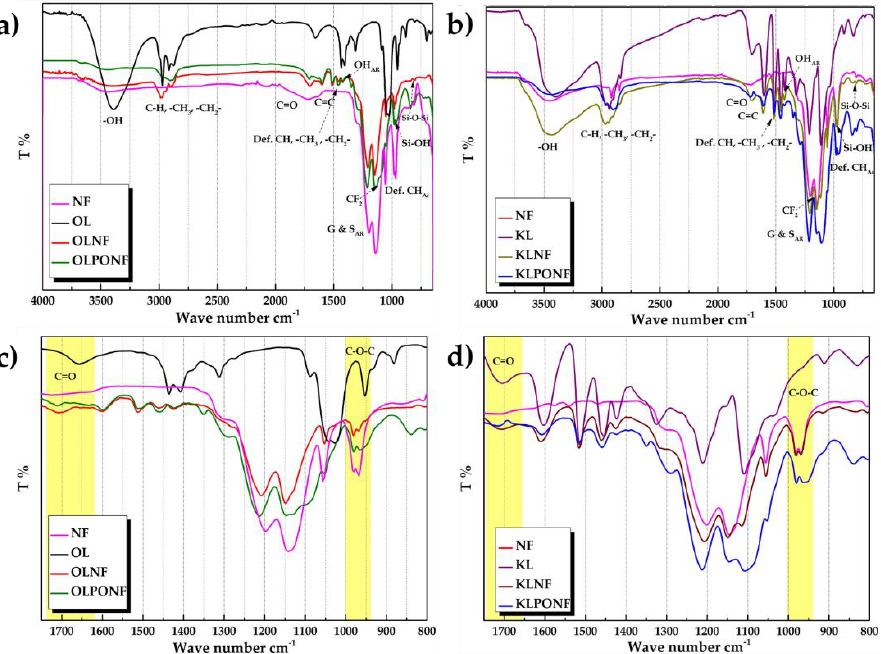
Figure 5. FTIR spectra of ( a ) OLPONF and OLNF composite in comparison to NF and OL, ( b ) comparison of C–O–R and C=O groups to demonstrate shift in peak. ( c ) KLPONF and KLNF composite in comparison to NF and blank kraft lignin, ( d ) comparison of C–O–R and C=O groups to demonstrate shift in peak.